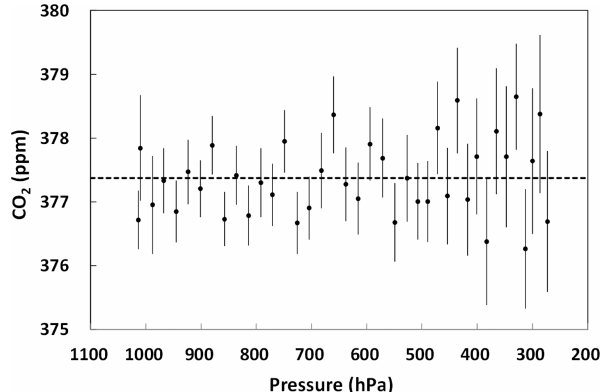
Figure 5. Results of a chamber experiment of the CO 2 sonde. Pres- sure in the chamber was reduced from 1010hPa (ground level pres- sure) to 250hPa (about 10km altitude pressure) at a temperature of about 298K. The black circles indicate the value of the CO 2 mole fraction of the sample air in the chamber, which was obtained from the interpolation of the standard gas values in each calibration cy- cle. Vertical error bars indicate the square root of the sum of squares for the standard deviations of the sample and standard gas signals at each step in the calibration cycle. The black dashed line shows an average of all the values obtained for the sample gas. See the text for more